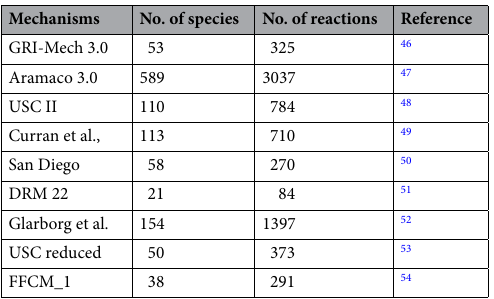
Table 1. Different mechanisms adopted in the present